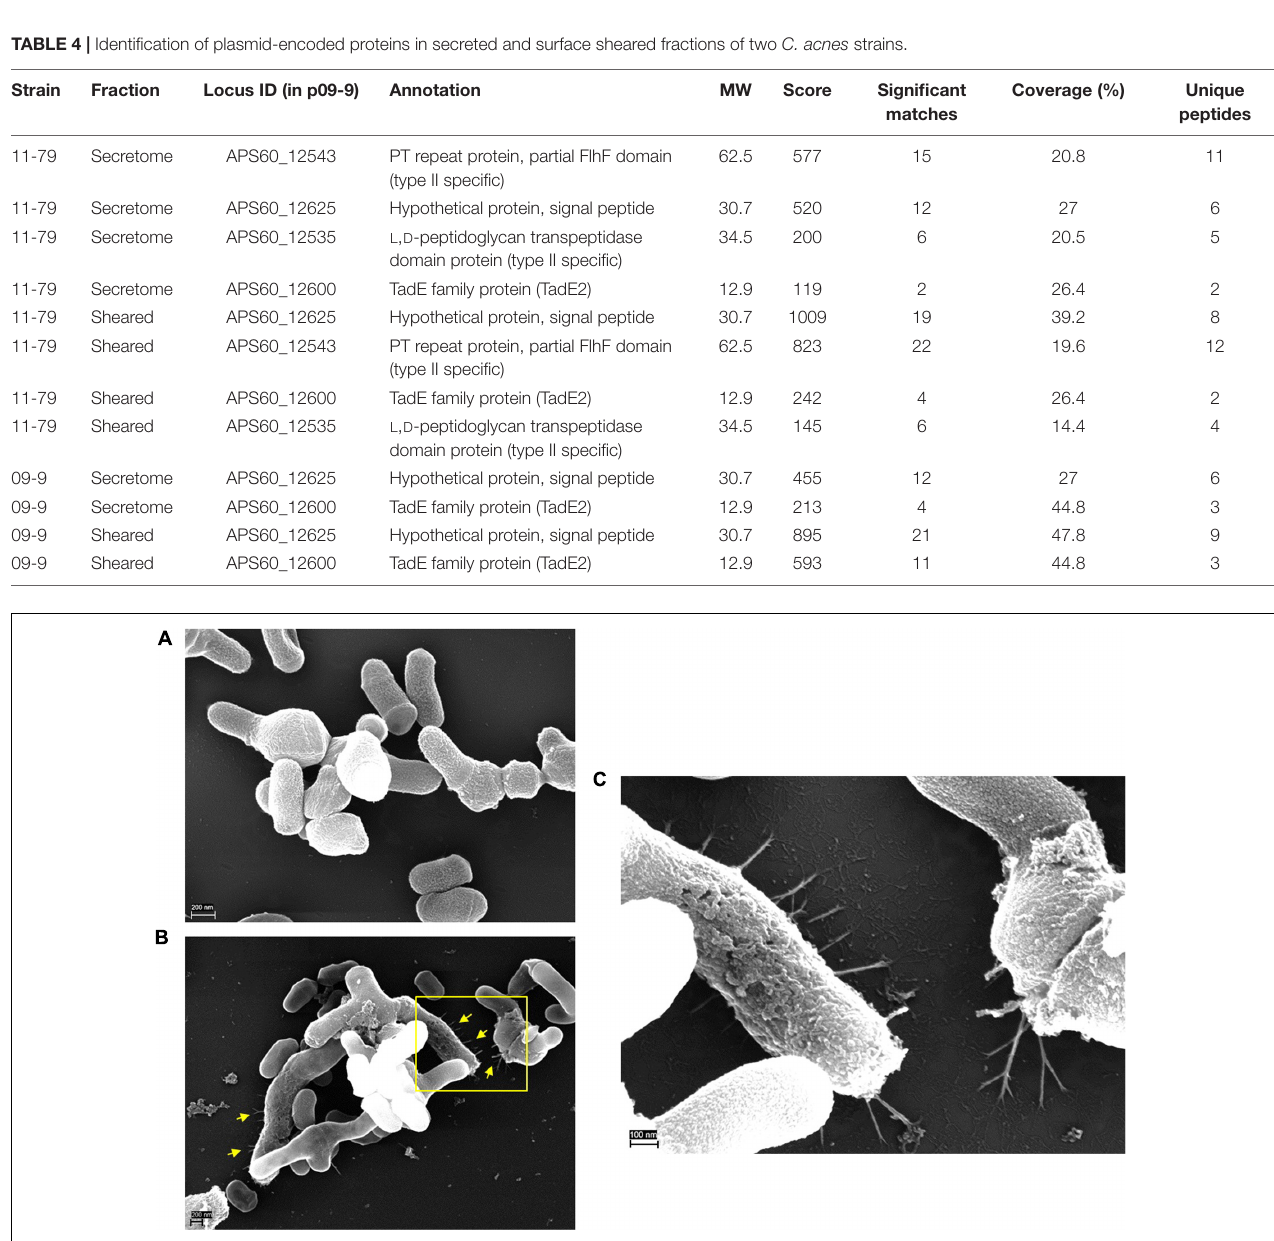
FIGURE 4 | Scanning electron microscopy of plasmid-negative and -positive C. acnes cells. (A) Plasmid-negative strain 11-88; (B) plasmid-positive strain 11-79; (C) zoom-in (B) . Note various cell appendages (yellow arrows). Scale bars are shown on each